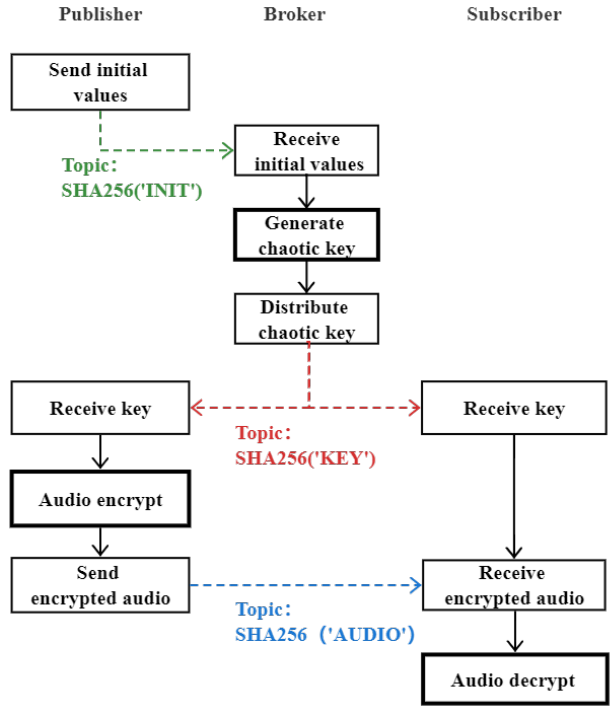
Figure 11. Flow chart of audio encrypt